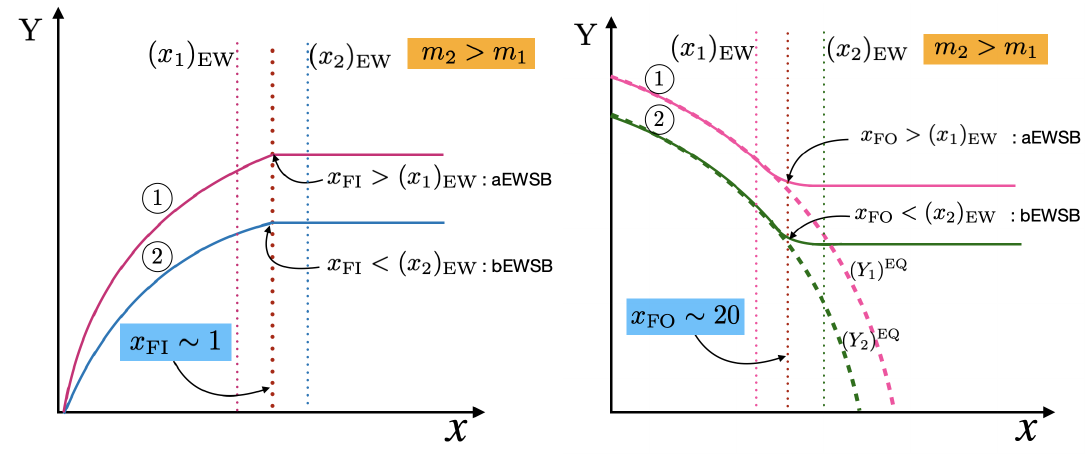
Figure 3 . Left: a cartoon freeze-in in the Y − x plane for two sample DMs with m 2 > m 1 which shows freeze-in aEWSB (in red) and bEWSB (in blue). Right: cartoon freeze-out which shows freeze-out aEWSB (in pink) and bEWSB (in green) from the respective equilibrium distributions (in dashed curves) shown in the right